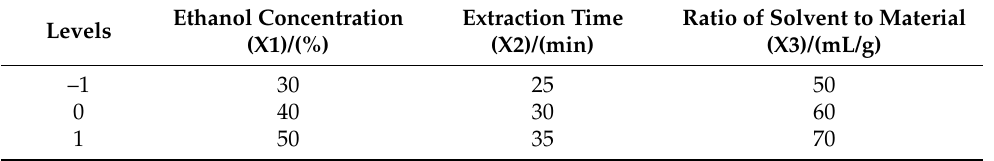
Table 1. Independent variables and their levels in BBD for TFW.